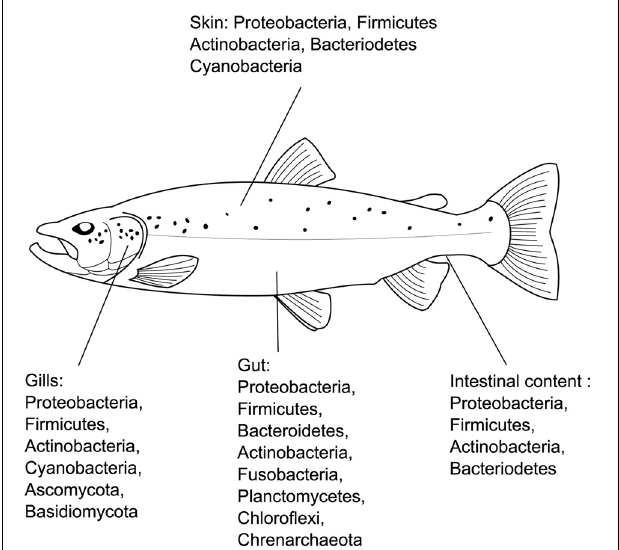
FIGURE 1 | General microbiological findings on fish microbiota. This overview synthesizes the major phyla present in the different organs of fish from different species. Bacterial phyla included are correspond to those which made up > 80% of sequences characterized from a given tissue/organ in each study. Only studies that employed direct sequencing (clone libraries/amplico-seq) are included.